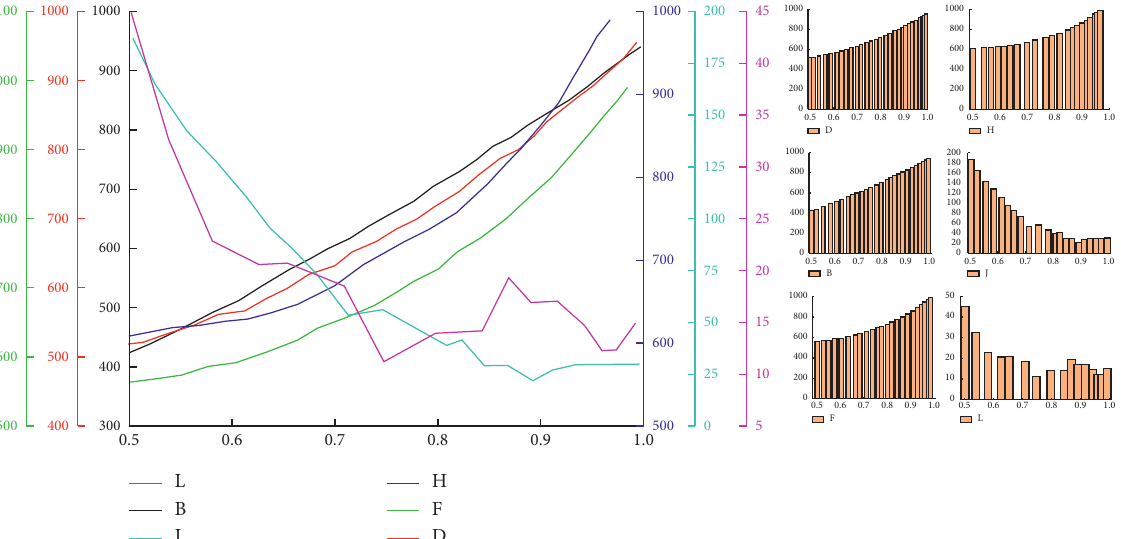
Figure 2: Influence of direct selling on optimal price.